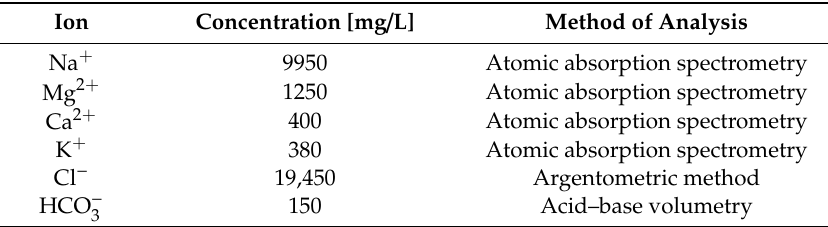
Table 1. Seawater ion concentration and method of analysis (pH